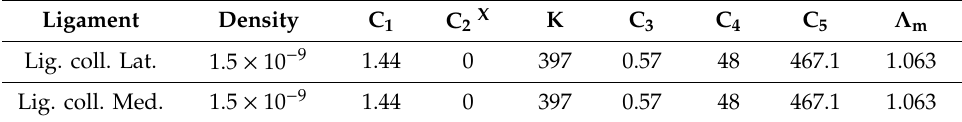
Table 1. Collateral ligament material properties used for finite element analysis (FEA). Lig. Coll. Lat. = ligamentum collaterale laterale (lateral collateral ligament); Lig. Coll. Med. = ligamentum collaterale mediale (lateral collateral ligament) C 1 , C 2 : Mooney–Rivlin coe ffi cients; K: Bulk modulus; C 3 : exponential stress coe ffi cient; C 4 : Fiber uncrimping coe ffi cient; C 5 : modulus of straightened fibers; Λ m: fiber stretch of straightened fibers. C X = 0 set zero to get a neo Hookean material [34] density in 2